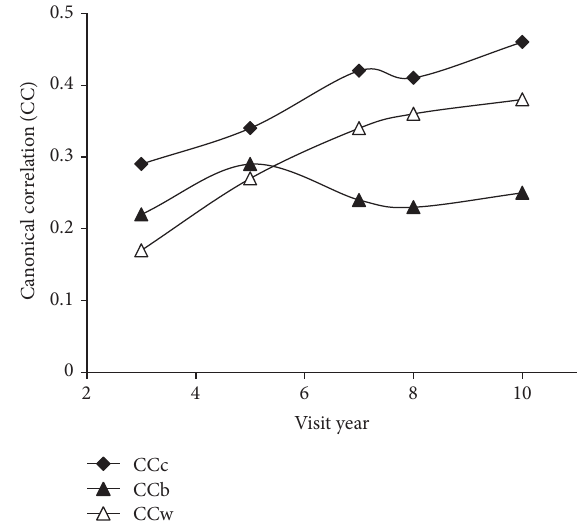
Figure 2: Canonical correlation of physical activity and con- founders with diet quality indicators by visit year. Physical activity and confounders: income category, race, maturation stage, height, weight, habitual physical activity questionnaire score (HAQ), 3-day activity diary score (3d AD), racial interaction HAQ, and racial interaction 3d AD; diet quality indicators: average energy density, average caloric intake, average dietary saturated fat percent, and average fiber intake. Lines represent stratified data from black (CCb) and white (CCw) girls and combined (CCc)